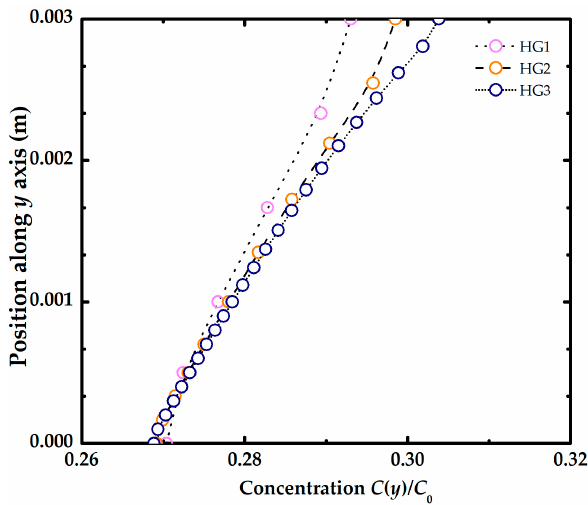
Figure 5. Diisopropyltelluride (DIPTe) concentration profiles C ( y ) / C 0 along the y -axis at the position of 0.03 m from the susceptor.